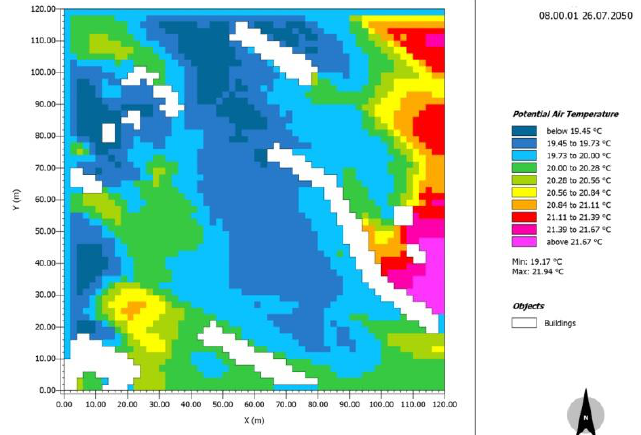
Figure 6. T3 simulation for 8 am, 26 July 2020 (image generated by ENVI-met).